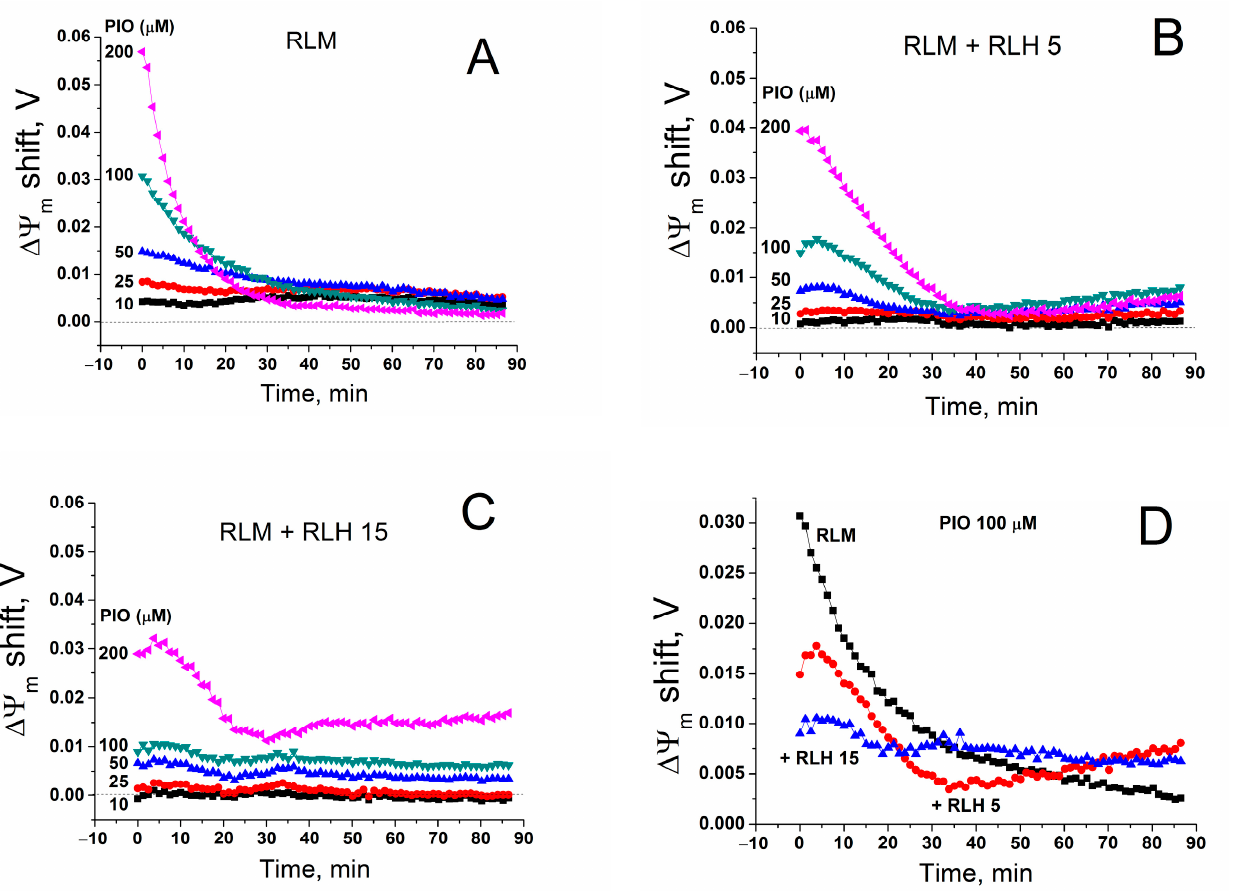
Figure 7. Effect of a cytosolic fraction (RLH) on PIO-dependent changes in ΔΨ m . Just before measurements, mitochondria alone (RLM) (0.75 mg prot./mL) ( A , D ) or in combination with 5 ( B , D ) and 15 mg prot./mL ( C , D ) of RLH were added to a standard incubation medium supplemented with 5 mM K + -succinate, 1 mM EGTA, rotenone (2.5 µg/mL), and 330 nM rhodamine 123, and then transferred to the wells of a 96-well plate, which contained 1% DMSO (Control), 10–200 µM PIO, or 500 nM FCCP, antimycin A (2.5 µg/mL), and valinomycin (25 ng/mL). Traces are the differences in ΔΨ m between PIO- and DMSO-containing samples in one representative experiment of three similar experiments.